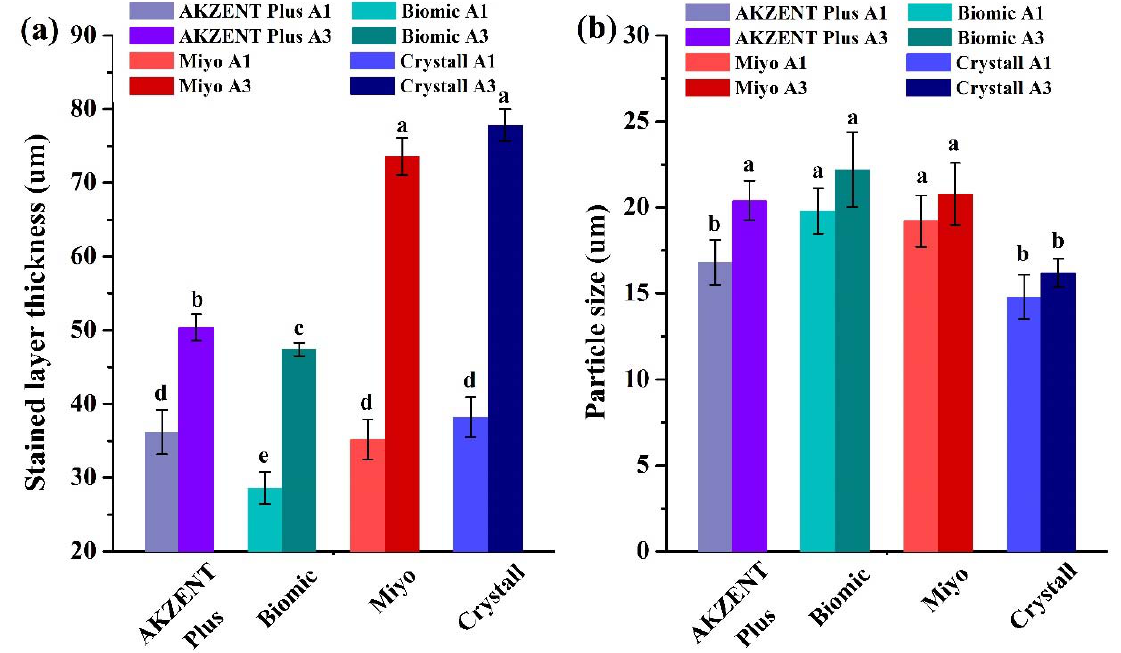
Figure 7. Comparison of the thickness of the zirconia samples after staining. ( a ) Thickness and ( b ) particle size. Means with different letters were significantly different ( p < 0.05, mean ± SD, n = 5).